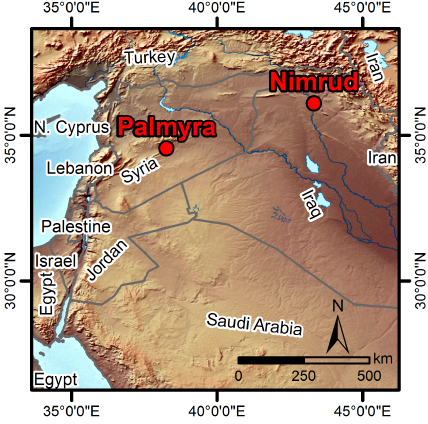
Figure 2. Map showing the locations of the two sites analyzed in this